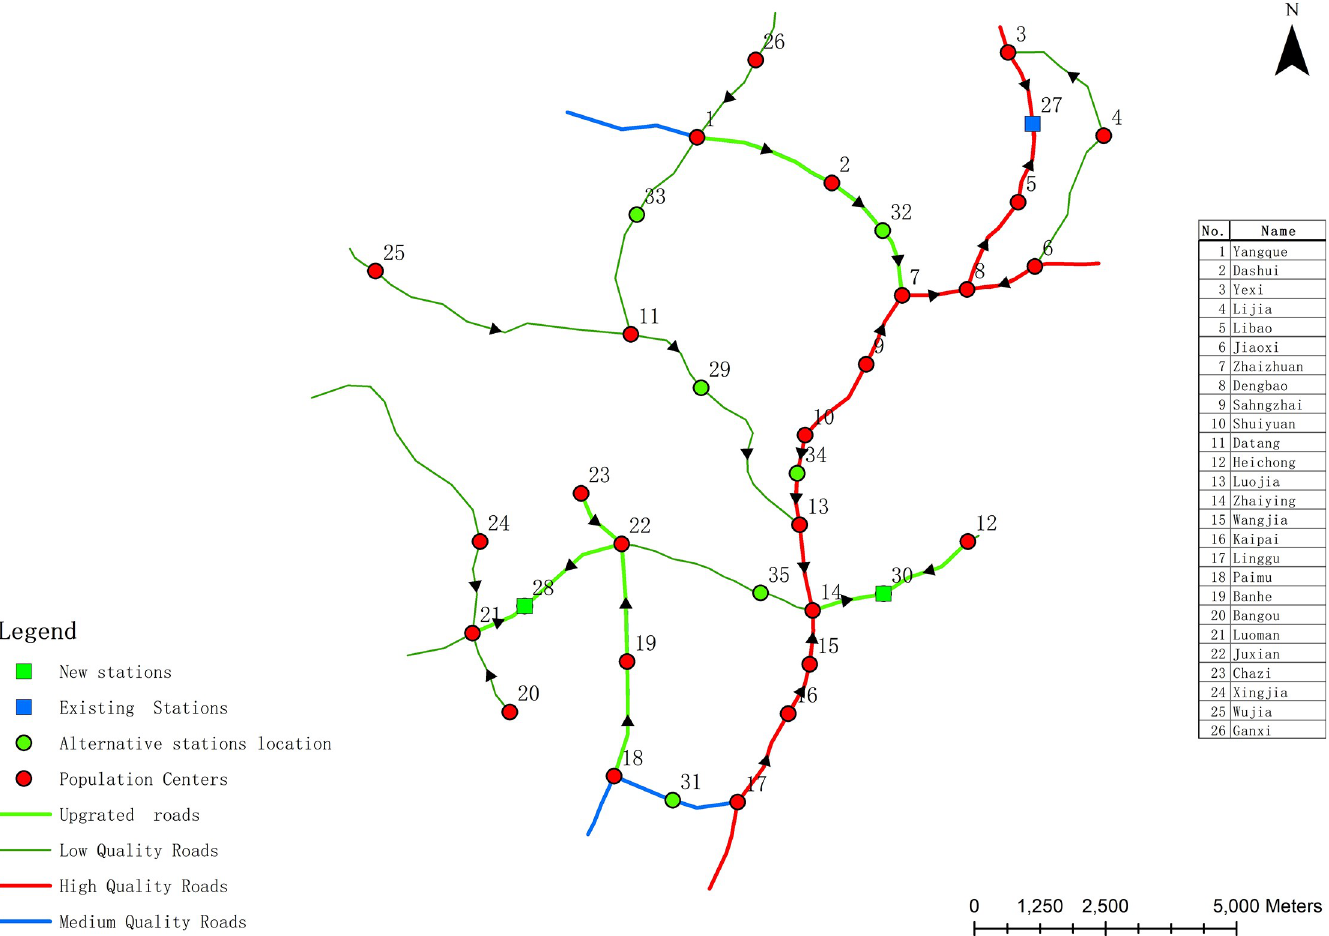
Fig 6. Waste transfer station layout and road upgrading results of scheme #26 under Model 2.